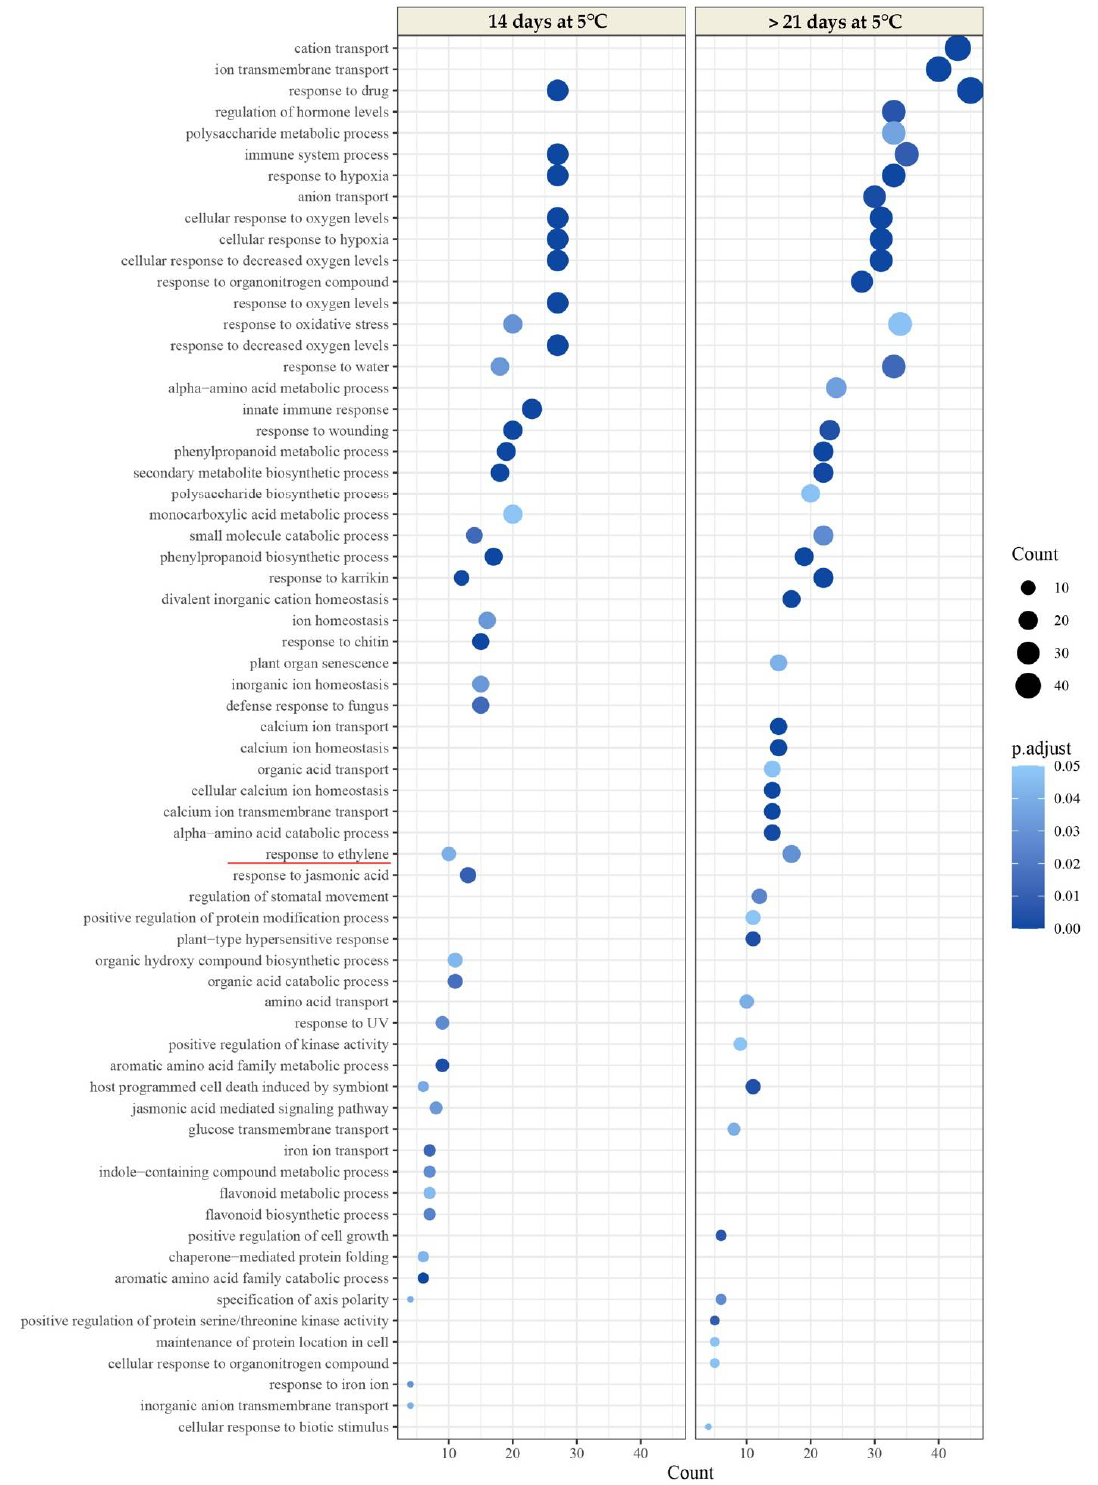
Figure 4. Dot plot of enriched Gene Ontology (GO) terms for the genes upregulated by cold storage compared with fruit at harvest of LDM. The Y-axis indicates the GO term, and the X-axis shows the count of genes per GO term. The input upregulated genes were 587 and 892 for 14 d at 5 ◦ C and >21 d at 5 ◦ C, respectively. The color gradient indicates the adjusted p -value (0.05) using the Benjamin-Hochberg method. The GO term ‘response to ethylene’ (GO: 0009723) is marked in a red line